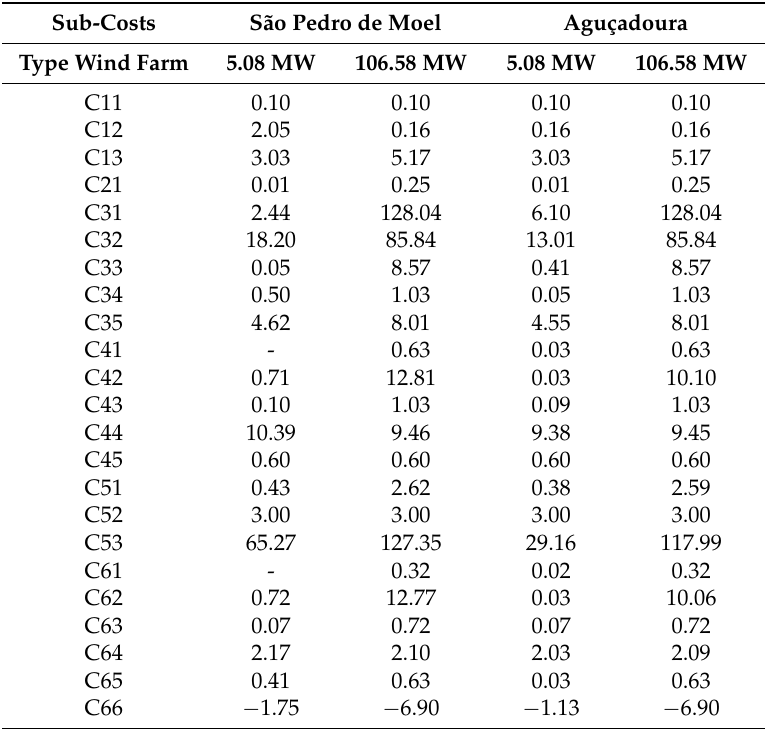
Table 9. Sub-costs of a 5.08 MW and 106.58 MW floating offshore wind farm.